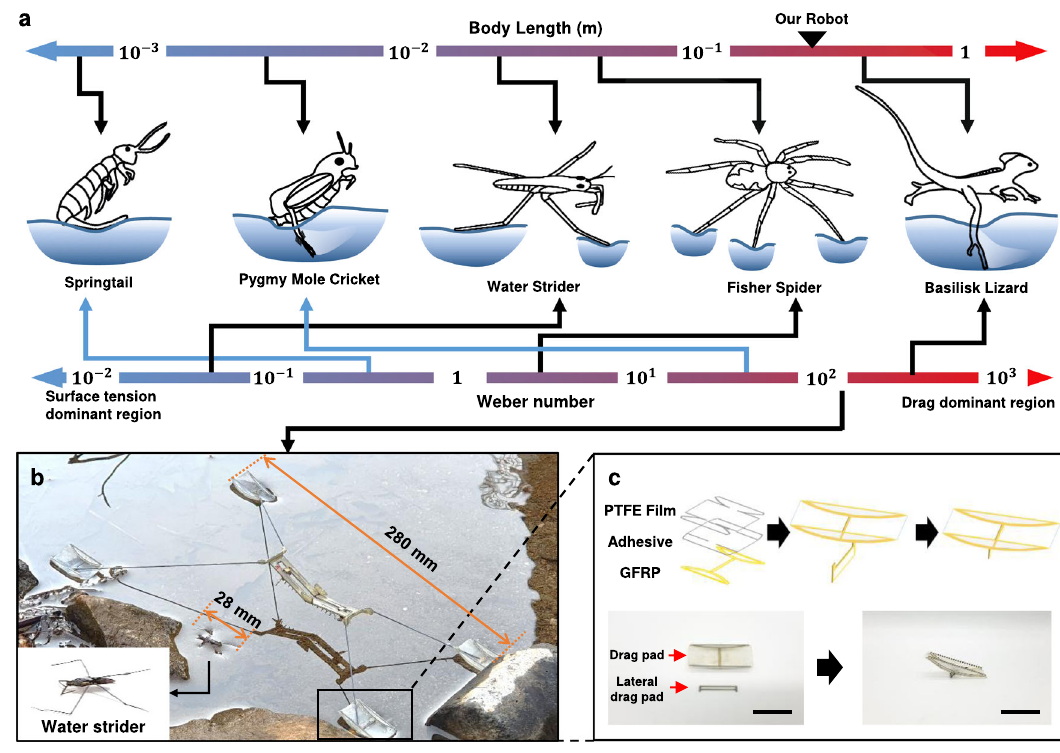
Fig. 2 | Scale of the semi-aquatic organisms and morphological design of the robotic insect. a A relationship between the body length and Weber number of animals jumping on water. b A large-scale robotic insect consisting of a shape memory alloy spring actuator and four semi-cylinder feet. The robot is designed